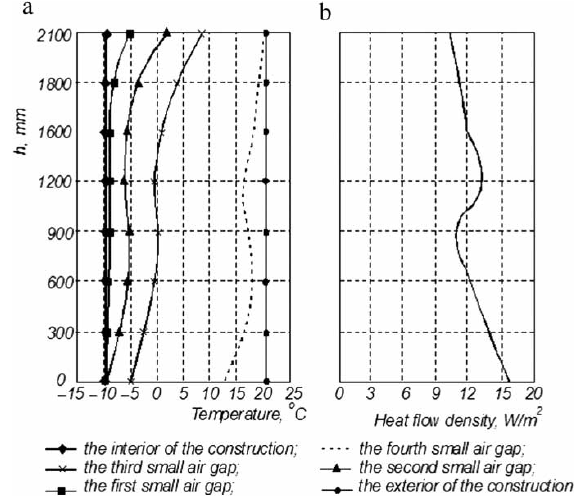
Fig. 8. Air temperatures (a) and heat flow density (b) of the gaps in the ventilated construction. The sample in the vertical position when u i (cid:2)(cid:4) 20 8 C, u e (cid:2) (cid:5) 10 8 C and Du (cid:2) 30 8 C